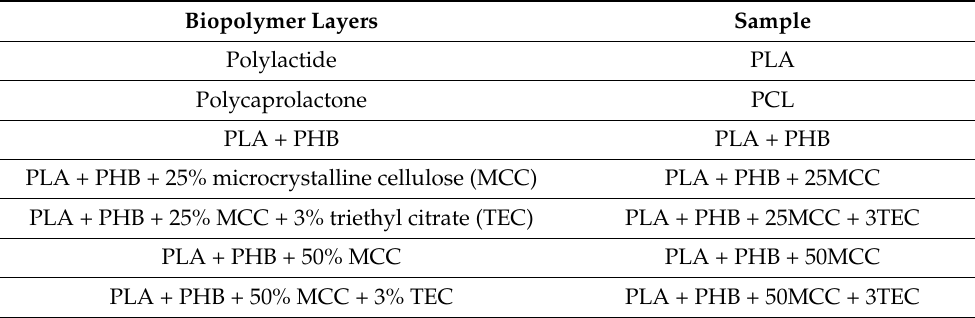
Table 2. Shortcodes for every elaborated composite. Biopolymer Layers Sample